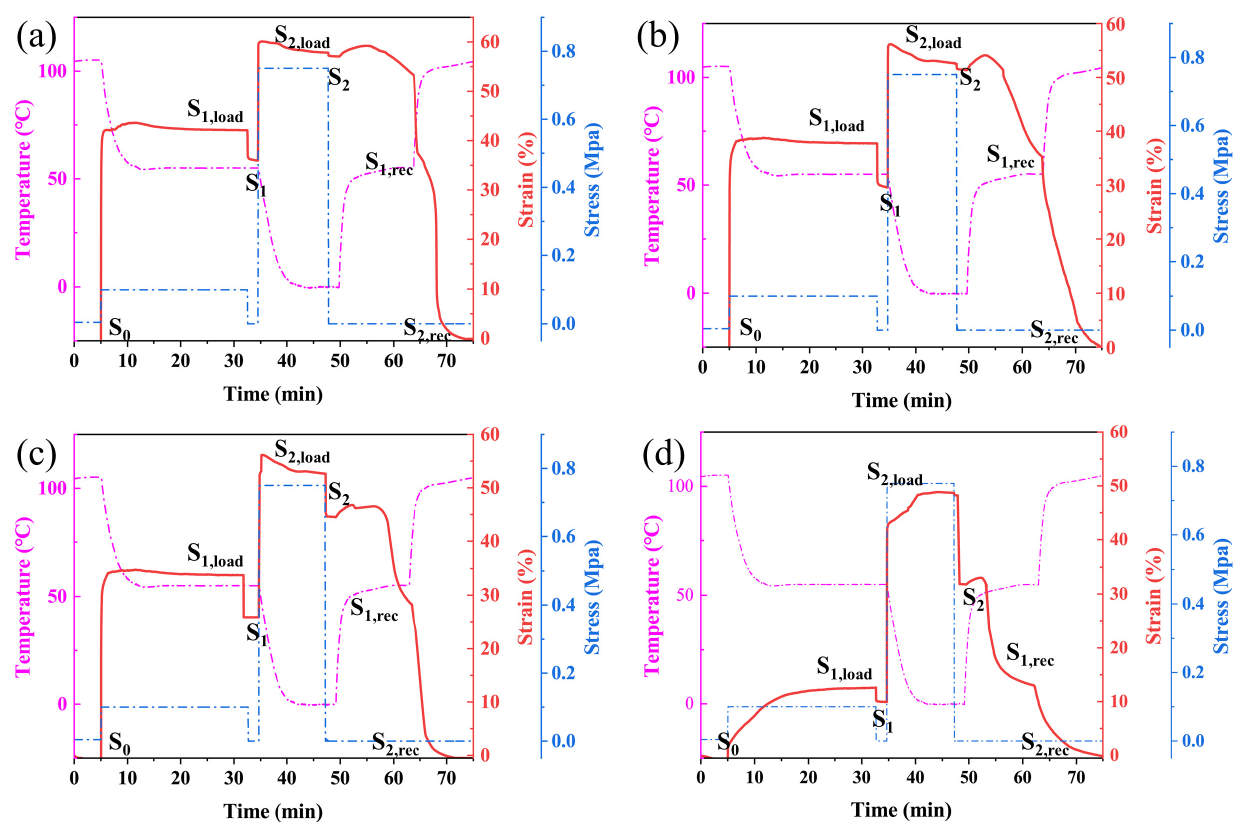
Figure 4. DMA curves of the triple memory shape memory behavior of the TPI/EVA composites: ( a )